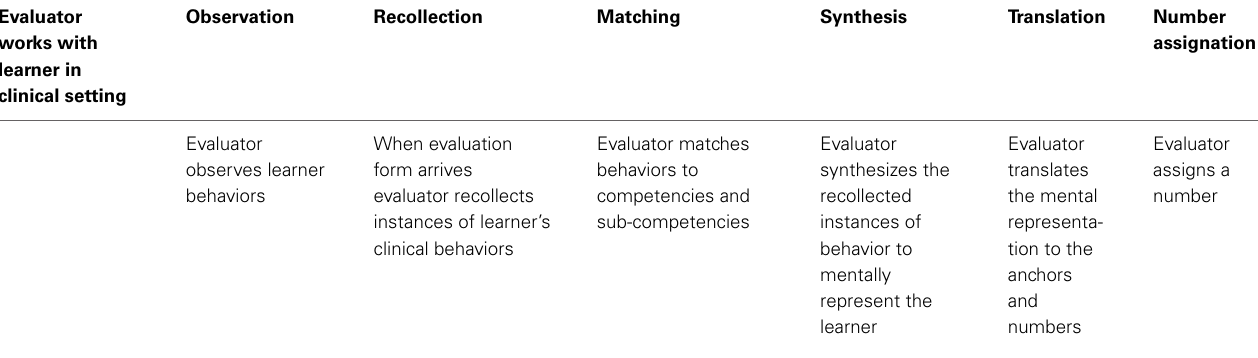
Table 1 | The evaluation process using numerical rating